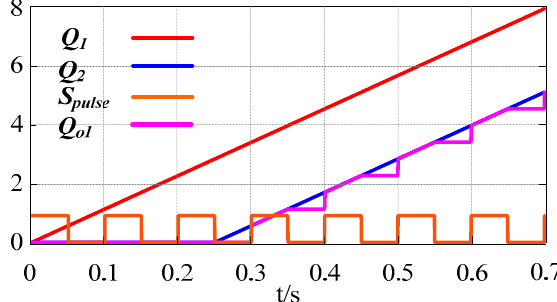
Figure 7. The simulated waveforms of the communication system.